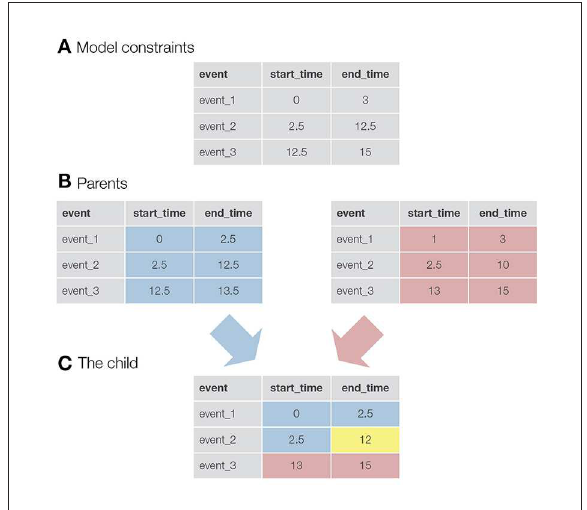
FIGURE1 A visualization of the logic behind genetic algorithms. (A) An example of constraints for a model with three events. For example, the constraints for event_1 specify that the onset for this event must be greater than 0 s and the end time must be less than 3 s. (B) The two parents selected to produce a child for the new generation. In this case, the values in the tables are not constraints, but the actual parameters of the events. For example, event_1 starts at 0 s and ends at 2.5 s. (C) A newly created child. Half of the events ( + 1, since we have an odd number of events) and their parameters come from the first parent (colored blue), while the rest of the parameters come from the second parent (colored red). The yellow colored parameter was taken from the first parent, but here a mutation event was triggered. This event reduced the final time of event_2 from 12.5 to 12